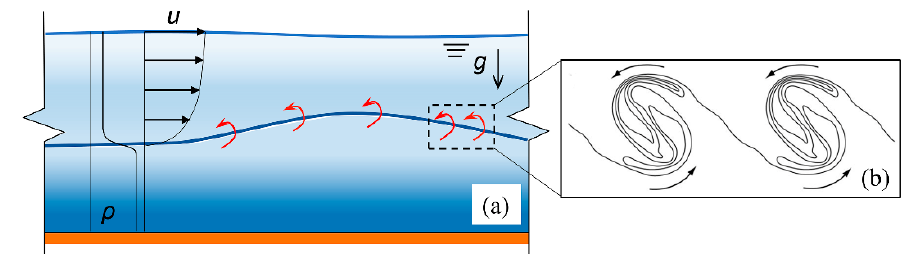
Figure 1. ( a ) Schematic of stratified shear flows in the density stratification water; there are many small-scale structures of K-H instability at the interface. ( b ) Schematic of K-H vortices (by Geyer et al. [1]).